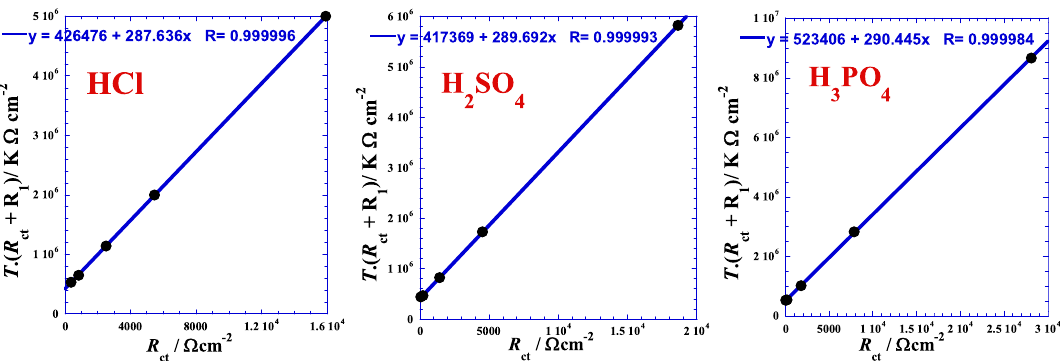
Figure 8. Linear dependence between the product T .( R ct + R 1 ) of Eq. (15) and the charge transfer resistance R ct for each